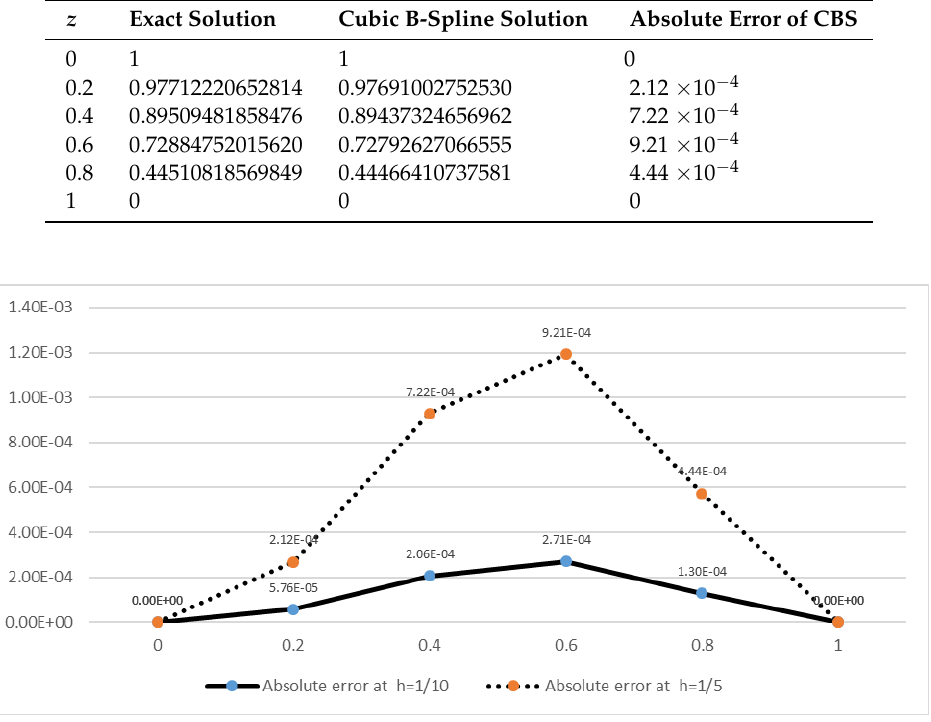
Figure 1. Graphical comparison of Problem 1 at h = 1